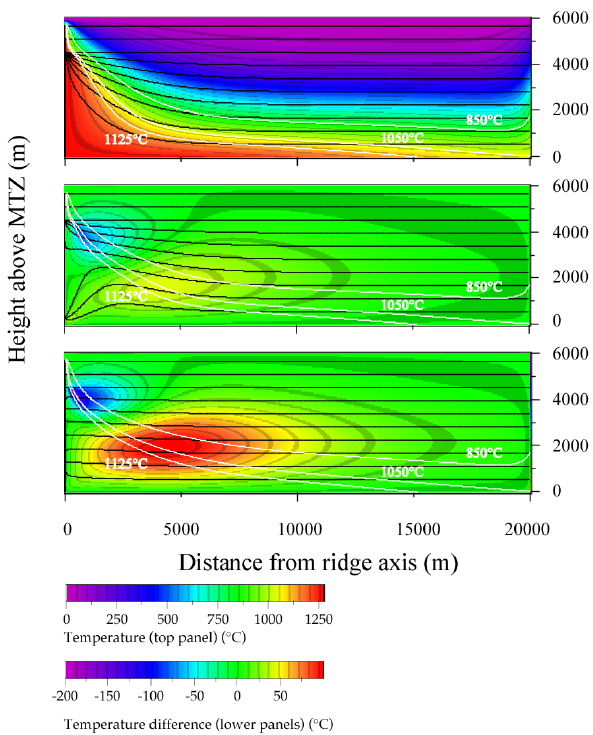
Figure 4: Same as Fig. 3 for a hydrothermal cracking temperature T crac = 1000°C. 786 Fig. 4. Same as Fig. 3 for a hydrothermal cracking temperature 787 T crac = 1000 ◦